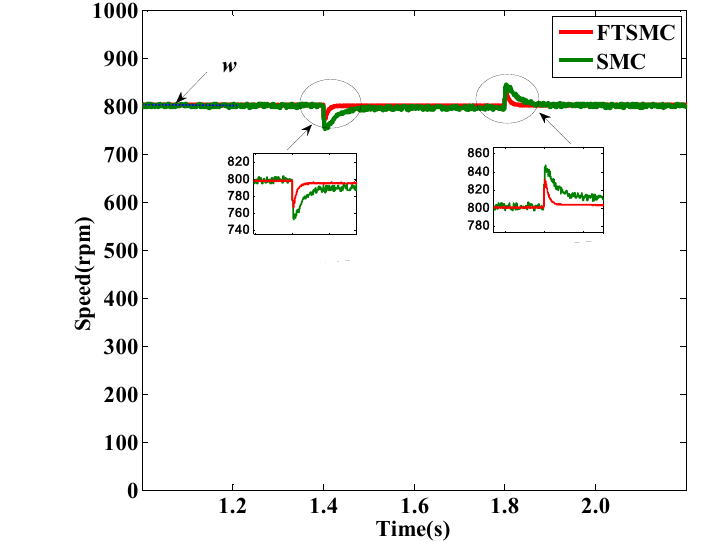
Figure 5. Starting speed curves.